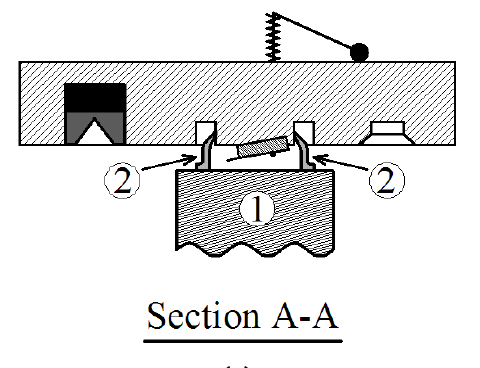
Figure 5. Cross section of the fluid cell defined in Figure 2 (a) before modification and (b) after modification. In this picture, (1) is the scanner, (2) is the o-ring, and (3) is the